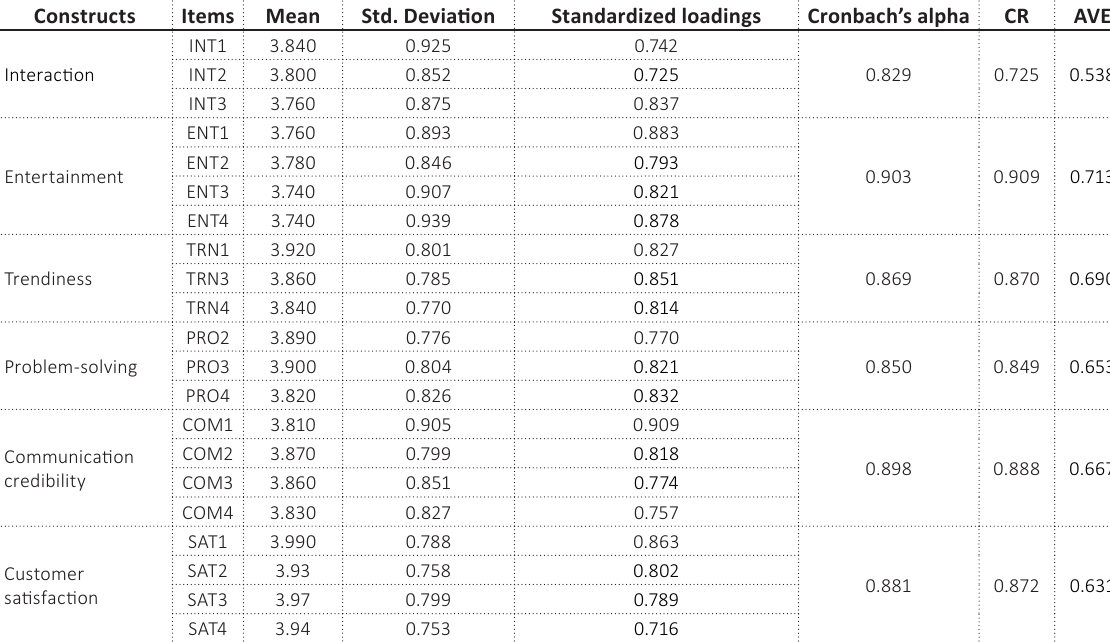
Table 3. Reliability and validity result Constructs